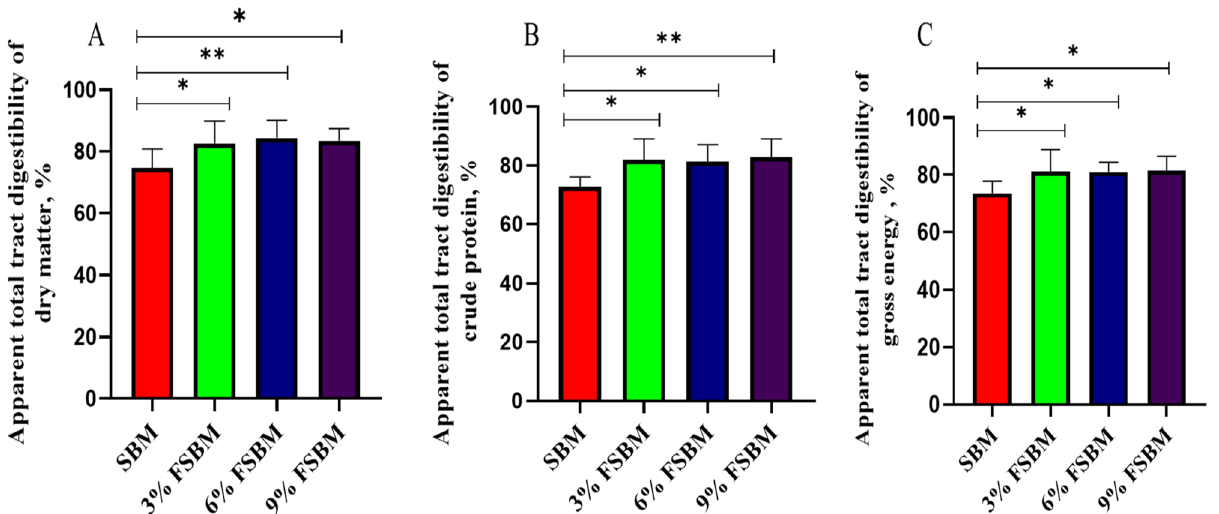
Figure 3. Effect of fermented soybean meal (FSBM) on apparent total tract digestibility in piglets. ( A ) Dry matter. ( B ) Crude protein. ( C ) Gross energy. * P < 0.05, ** P < 0.01. SBM, soybean meal; FSBM, fermented soybean meal.